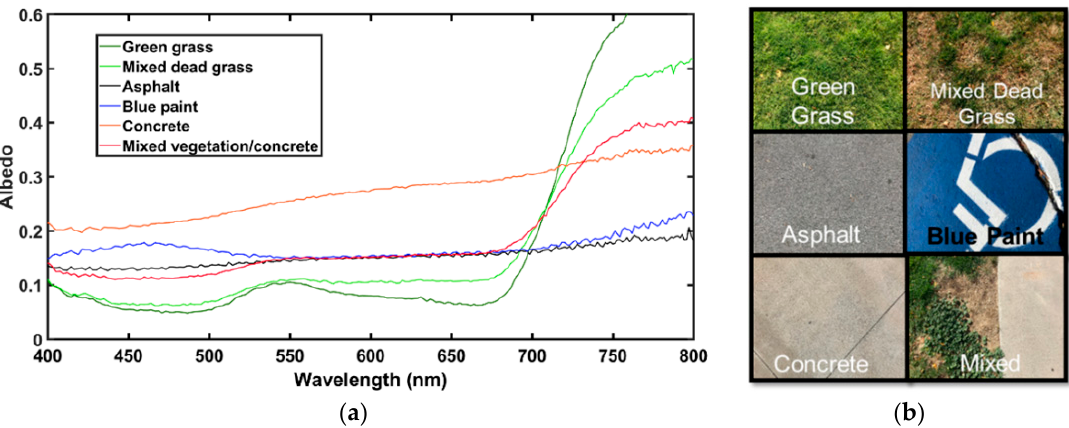
Figure 7. Initial testing of the instrument was performed over various surfaces around the University of Nevada, Reno (UNR) campus. The observed spectral signatures ( a ) align with expected signatures for the examined surface types ( b ). The data collected here were obtained using the instrument in the handheld version.